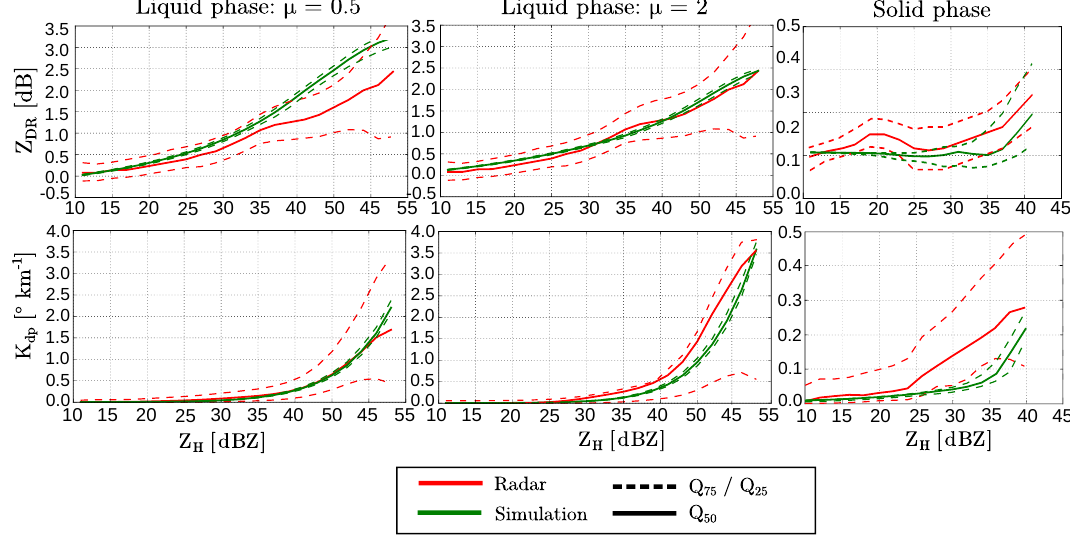
Figure 18. Observed (red) and simulated (green) Z H − Z DR and Z H − K dp relationships for the COSMO one-moment scheme in liquid and solid phases. These membership functions are computed by dividing all simulated values in bins of reflectivity of 1dBZ of width, and computing the quantiles of the dependent variable (on the y -axis) within every bin.